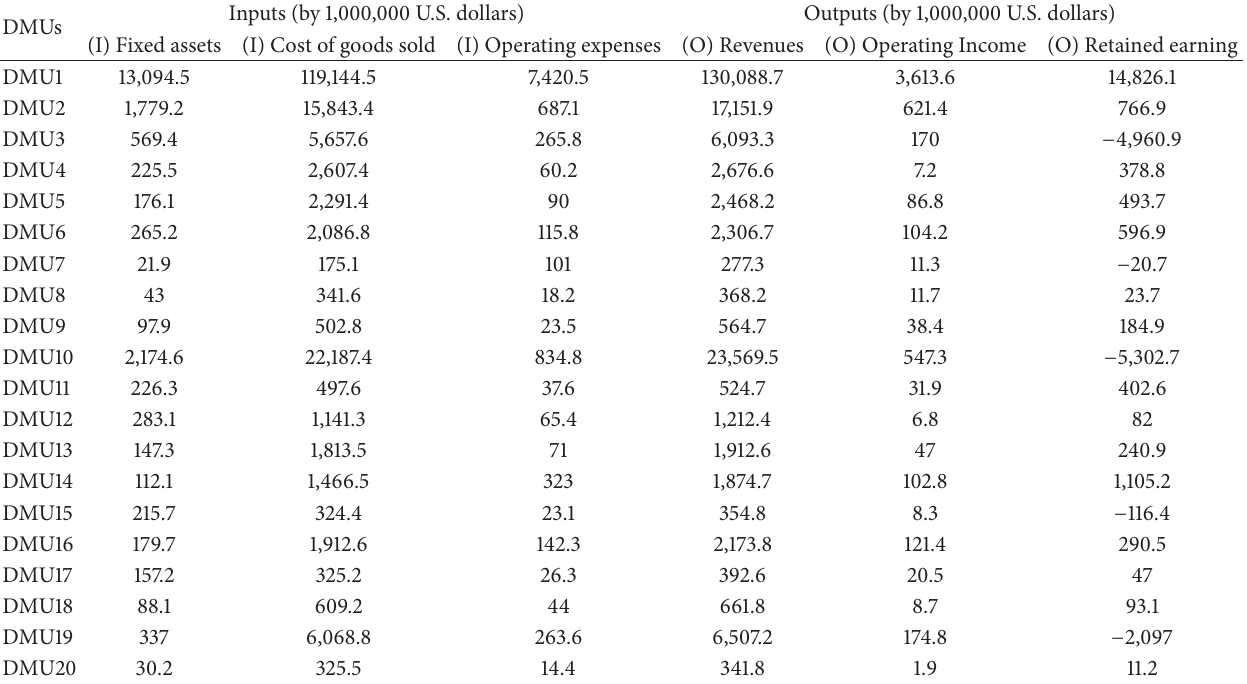
Table 2: Inputs and outputs data of all DMUs in 2012.